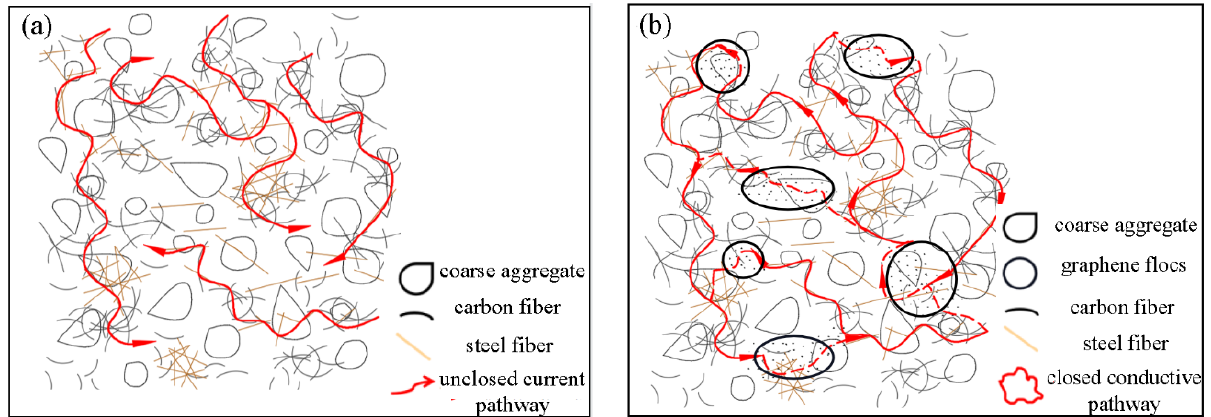
Figure 4. Diagram of conductive network of composite conductive concrete; ( a ) carbon fiber-steel fiber; ( b ) carbon fiber- steel fiber-graphene.